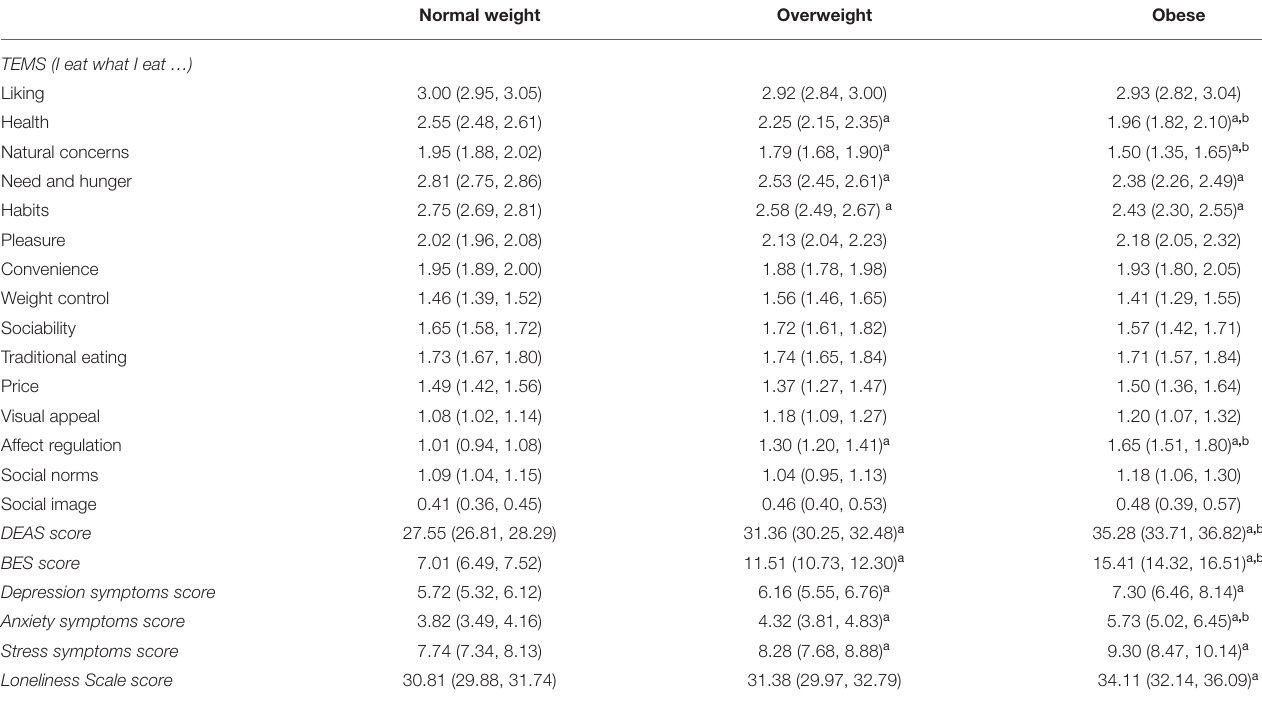
TABLE 2 | Food choice determinants and psychological symptoms during the COVID-19 quarantine among Brazilian women. Normal weight Overweight